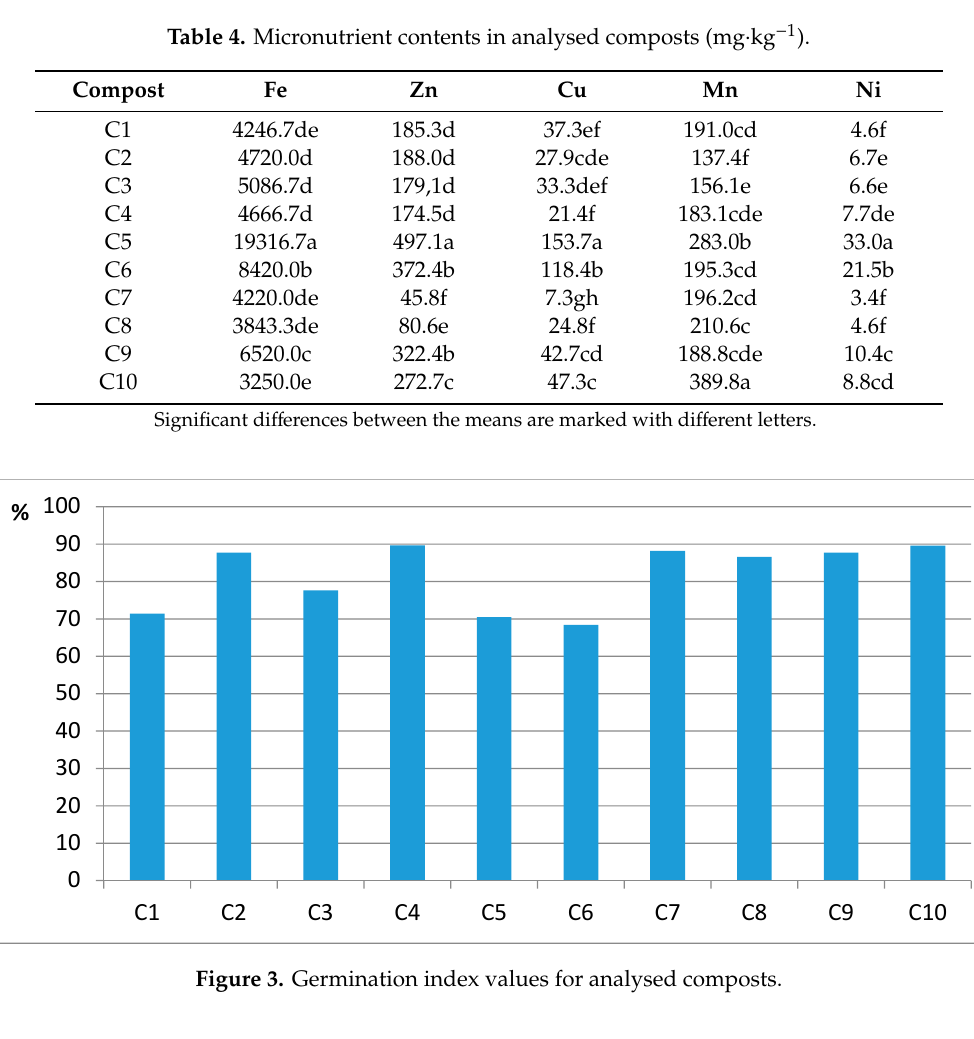
Figure 4. RGI and SGI values for analysed composts. When referring to the phytotoxic effects of the tested composts, the least harmful effects of C2, C4, C9, and C10 should be emphasised. These composts inhibited the germination of seeds within a very low range (from 0 to 4%), which was similar to the values for root growth (from − 22.1% to − 6.1%), while simultaneously the highest values of the GI index (from 87.7 to 89.6%) were determined (Figures 3 and 4). Despite the fact that the above-mentioned composts induced plant growth and development in a similar way, they differed in terms of their abundance in macro- and micronutrients, as well as the quality and quantity of humic compounds. As it results from the data in Tables 3 and 4 and Figure 2, composts 9 and 10 generally were characterised by higher contents of nutrients in relation to the levels found in composts 2 and 4. Particularly noteworthy is the large content of S (6.2 g·kg − 1 ), Na (1.4 g·kg − 1 ), Mn (389.8 g·kg − 1 ) and C FA (48.8 g·kg − 1 ) in C10. The highest values of HI (25.2%) and HR (37.8%) calculated for this compost need to be stressed in this respect (Table 2).